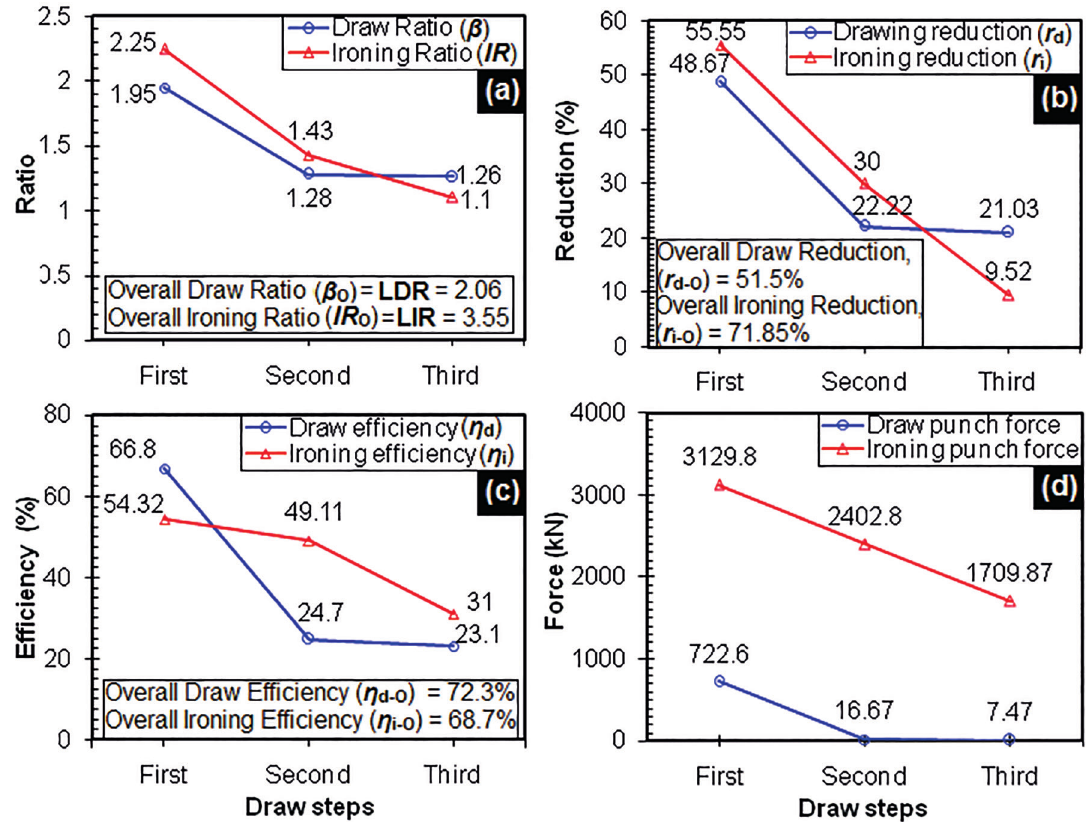
Figure 8: Stage wise graphical showing, a) Draw and Ironing Ratios, b) Draw and Ironing reductions, c) forming efficiencies, and d) punch